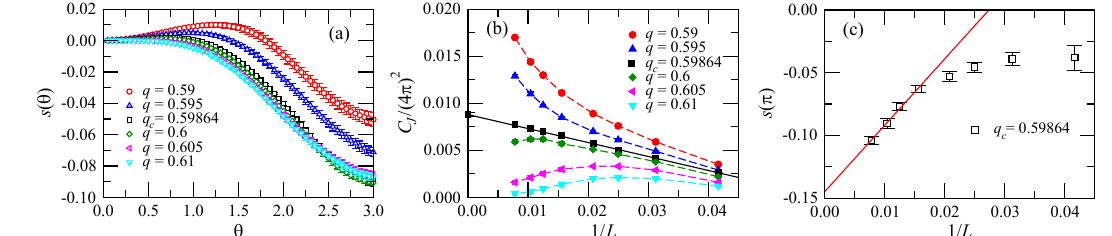
Figure 10: (a) The s ( θ ) as functions of θ with system size L = 96 and (b) the obtained / ( 4 π ) 2 as a function of 1 / L for different q in the vicinity of DQC. The different C J scaling behaviors in the two symmetry-breaking phases and at the DQC